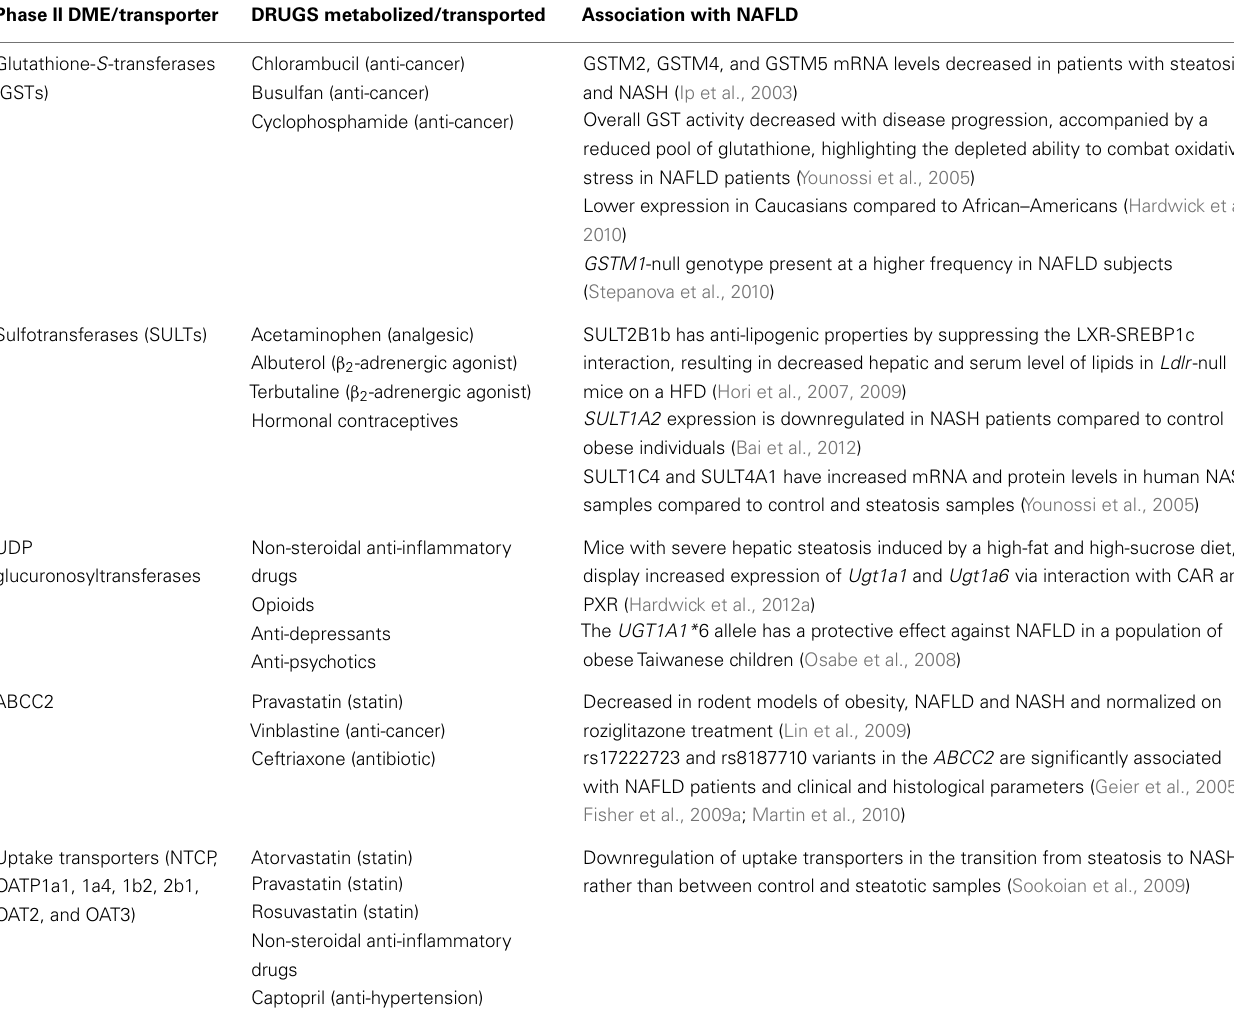
Table 3 | Phase II drug metabolizing enzymes and transporters implicated in the pathogenesis of